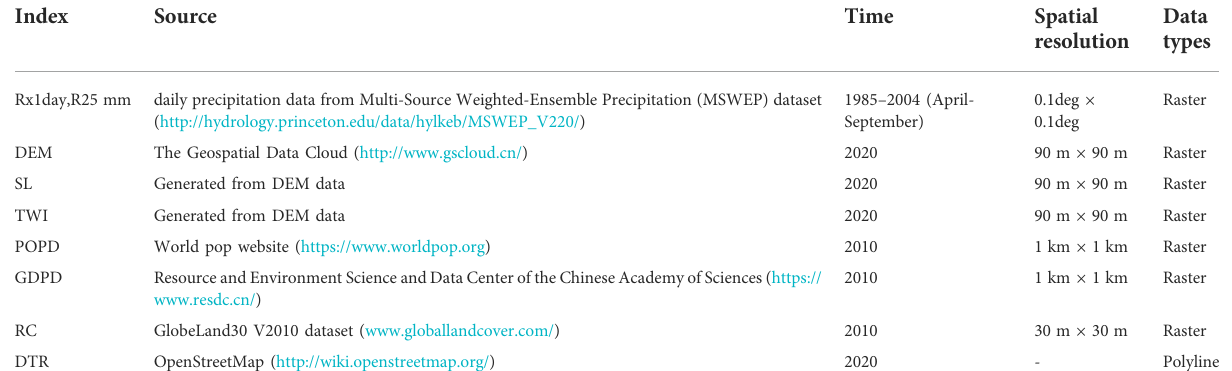
TABLE 1 The database for the historical